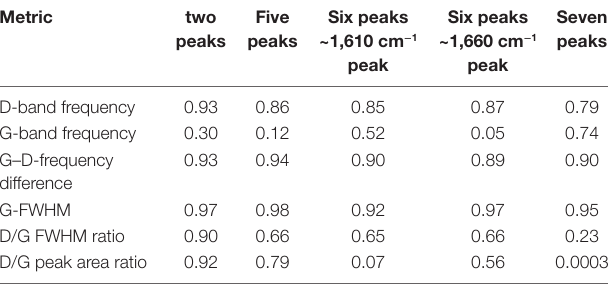
Table 5 | Coefficients of determination ( R 2 ) generated from correlation of Raman spectral metrics with sample-depth using different peak-fitting strategies. Metric two